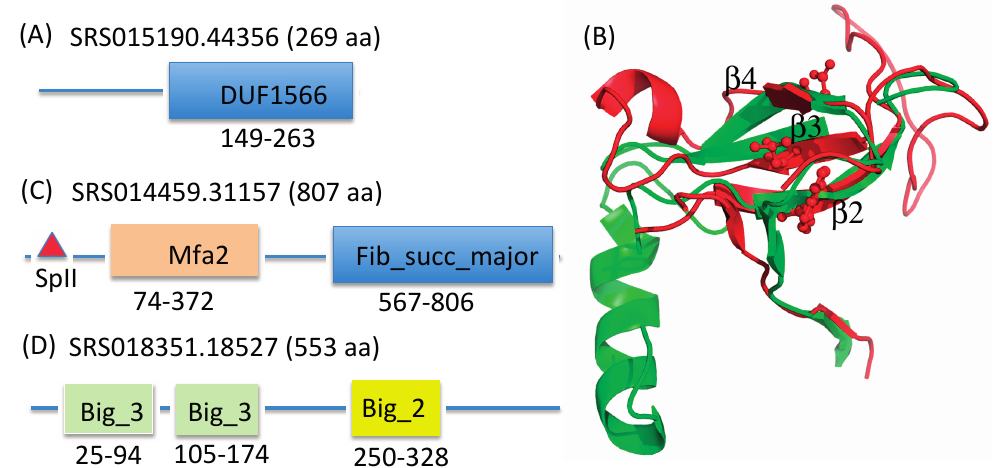
Alignment between the VR in SRS018351.18527 and its matching TR (E)